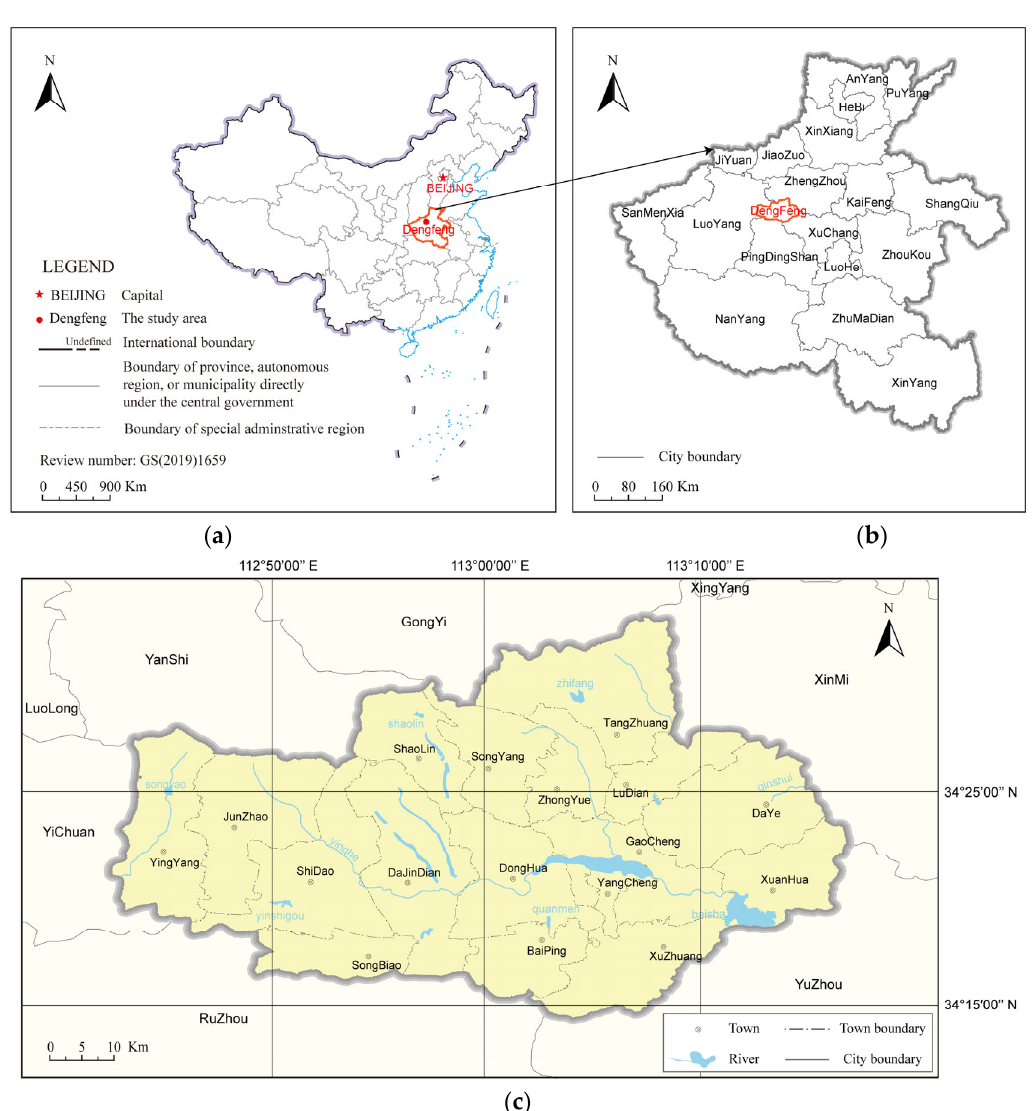
Figure 1. Location and administrative division of Dengfeng: ( a ) the location of Dengfeng in China, this map of China is mainly provided by the Ministry of Natural Resources of China; ( b ) the location of Dengfeng in Henan Province; ( c ) the administrative division map of Dengfeng city.